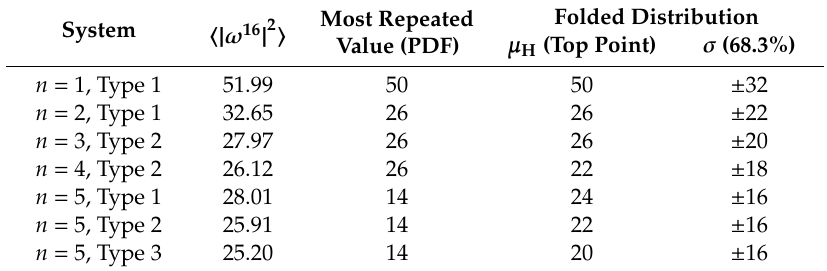
Table A13. Statistical parameters of SAW size for the SC restricted lattice as a function of system characteristics (fixed: N = 16) for selected systems.